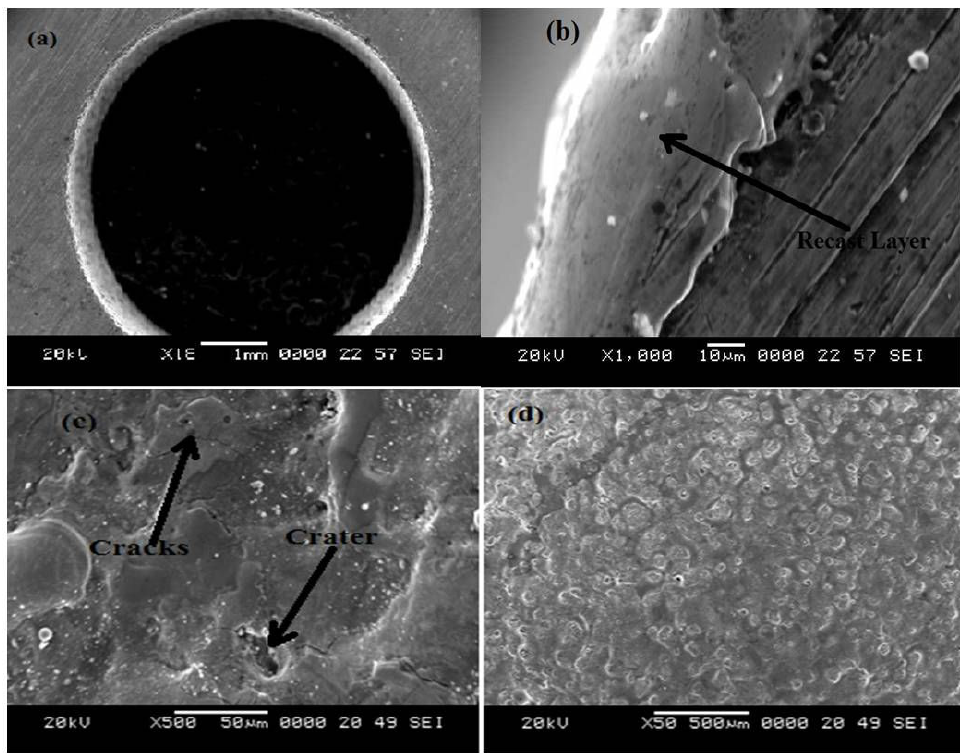
Figure 13: SEM micrograph: Exp No. 5; at T on = 10 µ s; T off = 30 µ s; Ip = 2A